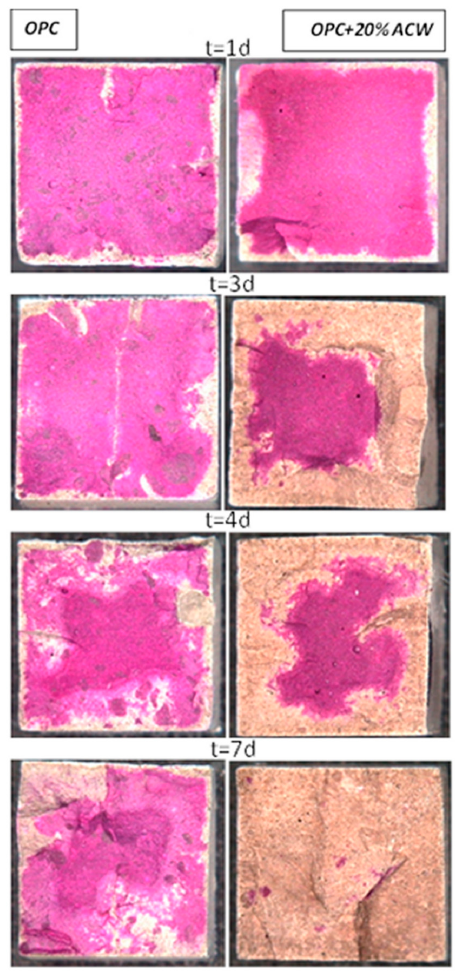
Figure 1. Variation in carbonation front with exposure time.